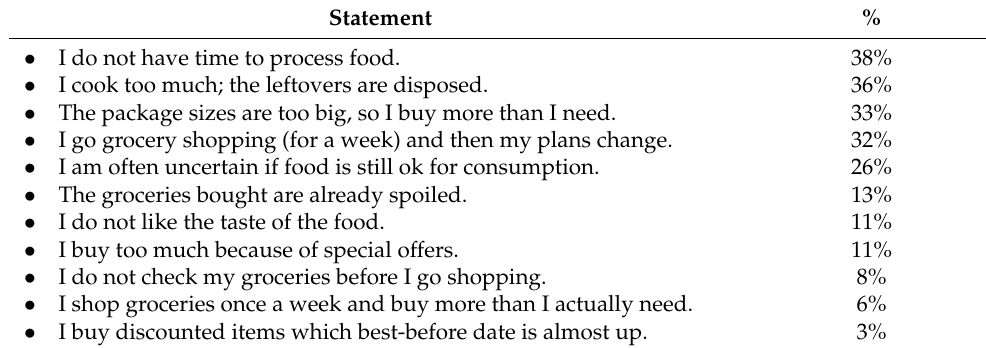
Table 7. Causes and driving forces behind food disposal (multiple answers).